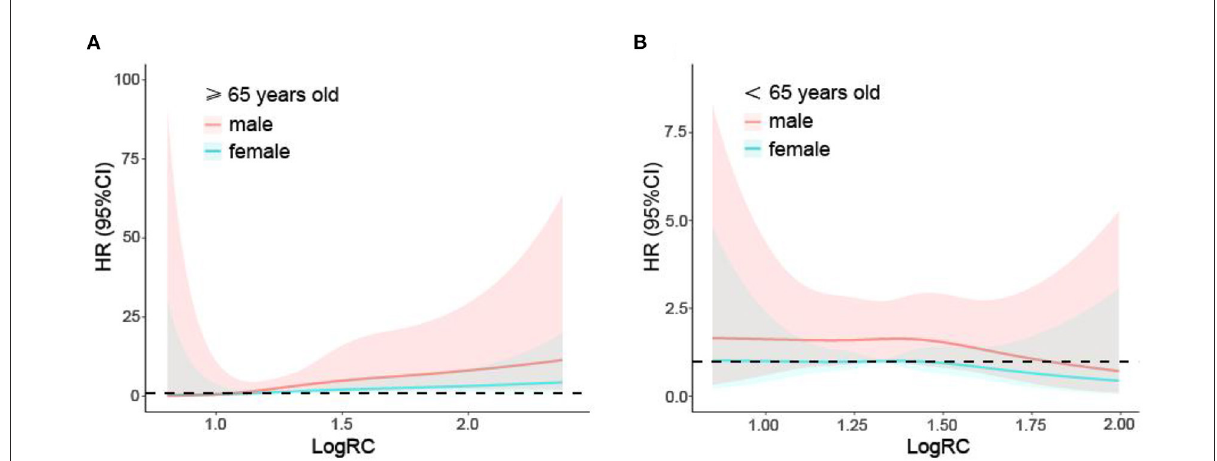
FIGURE3 Restricted cubic spline plots of the association between log10-transformed RC and cardiovascular mortality in the general population over (A) and below 65 years (B) by sex. Analysis was adjusted for age + sex + race + antihypertensive medications + lipid-lowering medications use + systolic blood pressure + coronary heart disease + stroke + smoking. HR, hazard ratio; CI, confidence